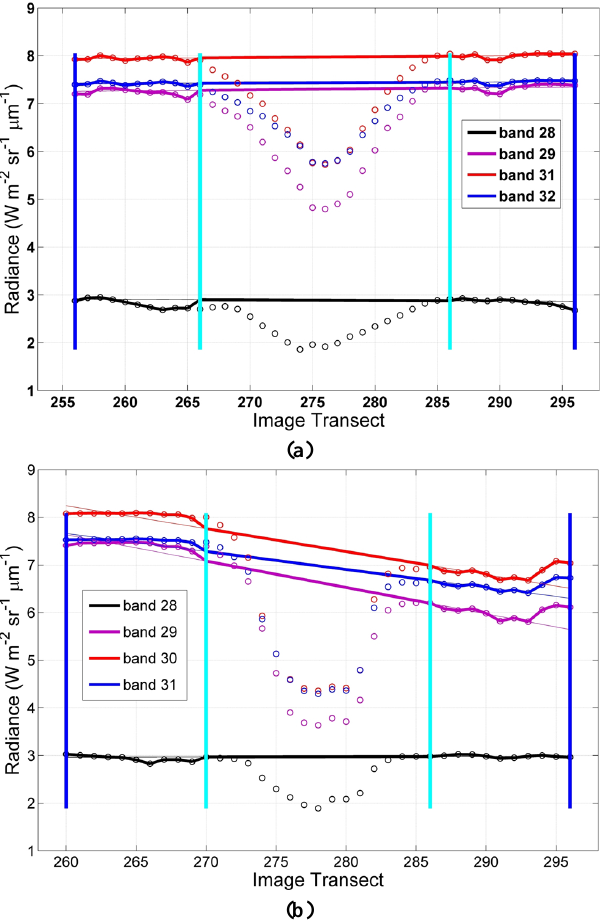
Fig. 1. (a) Radiance of the MODIS bands 28, 29, 31, and 32 in a transect perpendicular to the plume axis over the ocean. Circles: measured radiance. Thick lines: radiance without plume. Thin lines: straight-line tangent to absorption feature (plume) obtained consid- ering only the points between the blue and cyan bars. (b) Radiance of the MODIS bands 28, 29, 31, and 32 in a transect perpendicu- lar to the plume axis over both ocean (left) and land (right). Circles: measured radiance. Thick lines: radiance without plume. Thin lines: straight-line tangent to absorption feature (plume) obtained consid- ering only the points between the blue and cyan